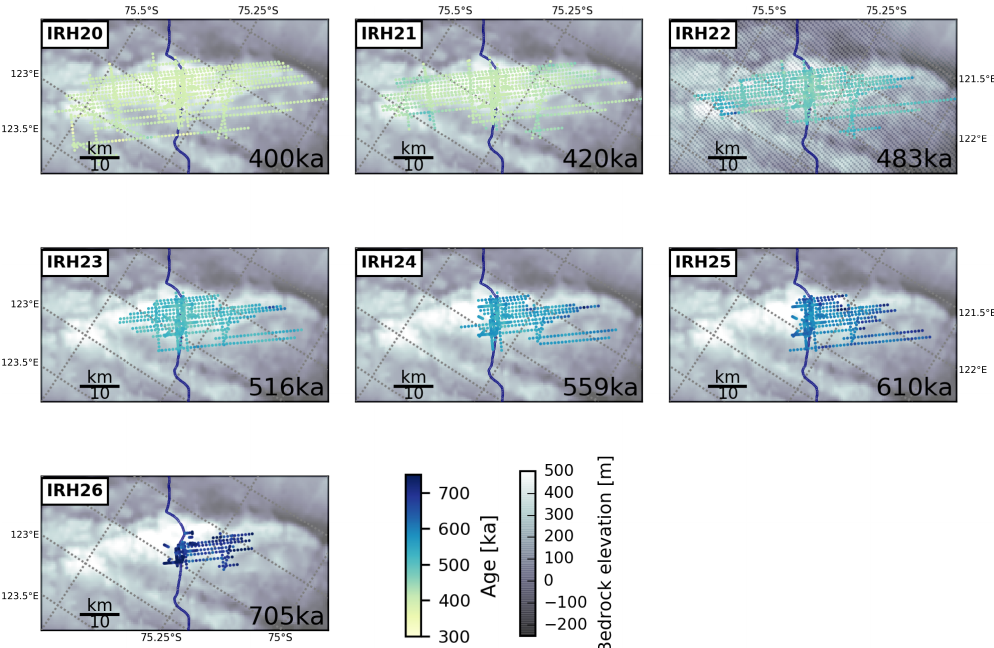
Figure 8. Spatial distribution of modeled ages for the seven bottom IRHs over the Dome C region of the East Antarctic Plateau, overlain on Young et al. (2017) bed elevations. The area covered by each panel is outlined by a black dashed box in the first panel of Fig. 6. The color scale represents the predicted age of the model-dated IRHs, interpolated from the modeled age–depth field. The navy line outlines the position of the ice divide (Zwally et al.,